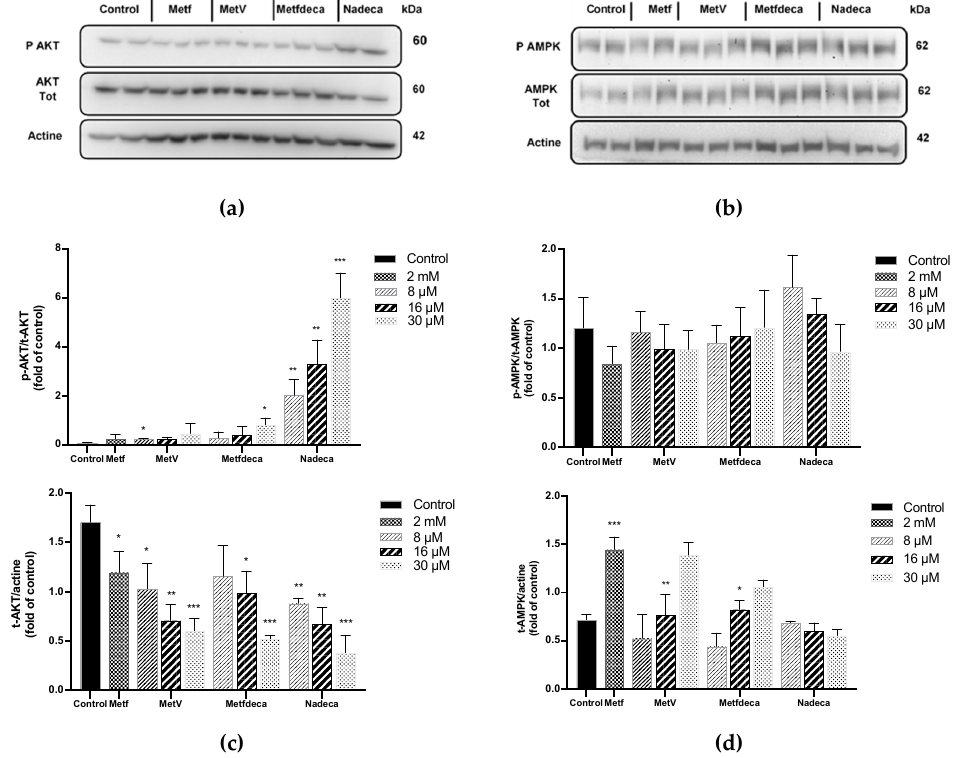
Figure 5. Effect of vanadium compounds on the protein expression of ( a ) protein kinase B (AKT) representative Western blot and ( b ) AMP-activated kinase (AMPK) representative Western blot in HEPG2 human hepatocarcinoma cells. Metf 2 mM and vanadium compounds 8, 16 and 30 μM concentrations, respectively, from left to right. Quantitative data of ( c ) p-AKT/t-AKT and t-AKT/actine ( d ) p-AMPK/t-AMPK and t-AMPK/actine. All the values are the mean ± SD. * p < 0.05, ** p < 0.01 and *** p < 0.001 vs. untreated control cells.